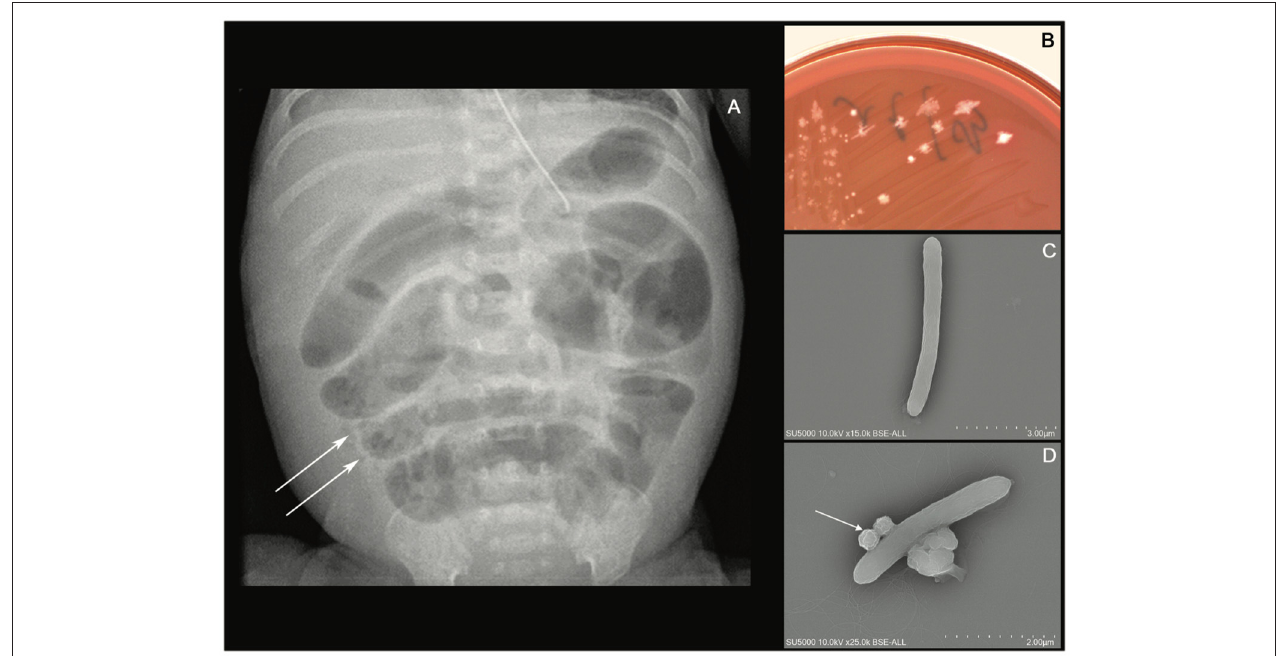
FIGURE 1 | (A) Abdominal X-ray showing intramural bowel gas also known as pneumatosis intestinalis , (B) culture growth of cream-colored colonies on COS after 24h of incubation at 37 ◦ C in the anaerobic chamber, (C) Clostridium neonatale rod-shaped cells using Hitachi SU5000 scanning electron microscope. Scale bar and acquisition settings are shown on the original micrograph, and (D) sporulating C. neonatale cell.